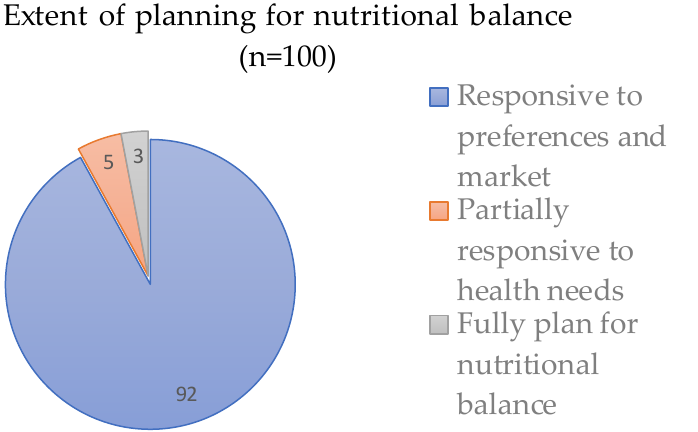
Figure 2. How survey respondents report balancing market needs against health and nutritional needs when grocery shopping.